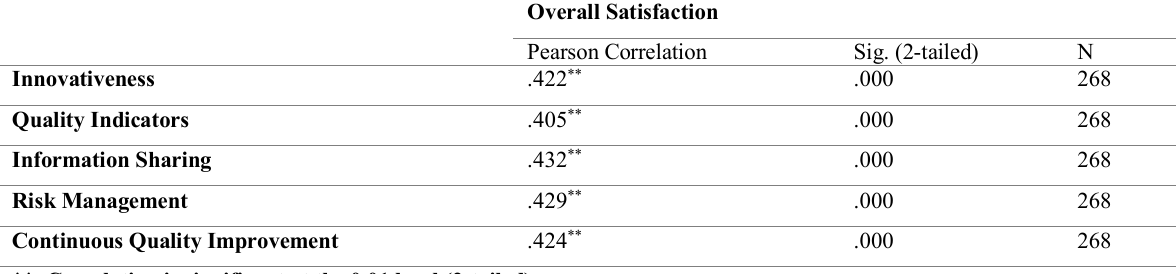
Table 8: Correlation between continuous quality improvement and patient satisfaction Overall